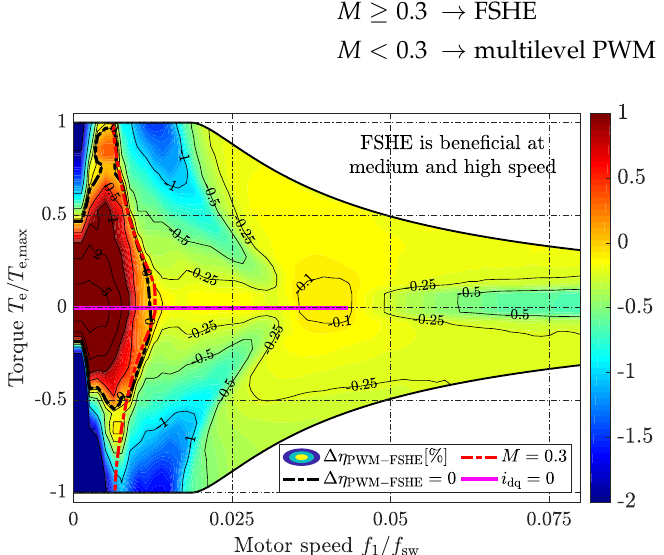
Figure 14. Obtained simulated, absolute difference in combined inverter and battery efficiency η Inv η Bat between multilevel PWM and FSHE, ∆ η PWM − FSHE